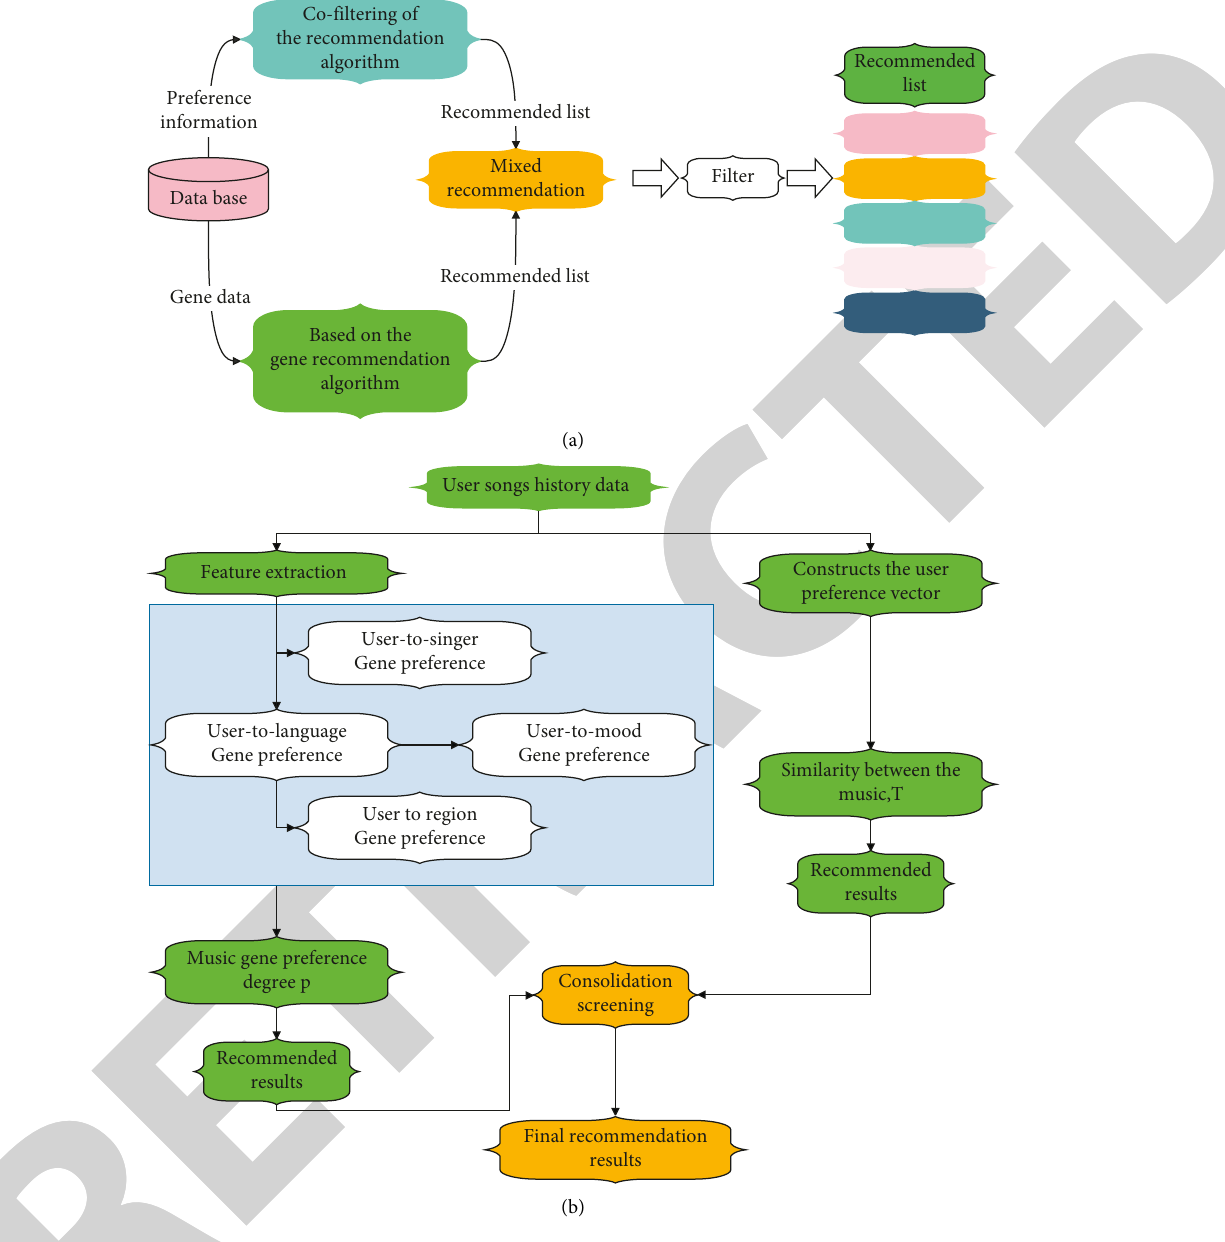
Figure 8: Flowchart of the music recommendation algorithm. (a) Overall algorithm flowchart. (b) Refinement system algorithm